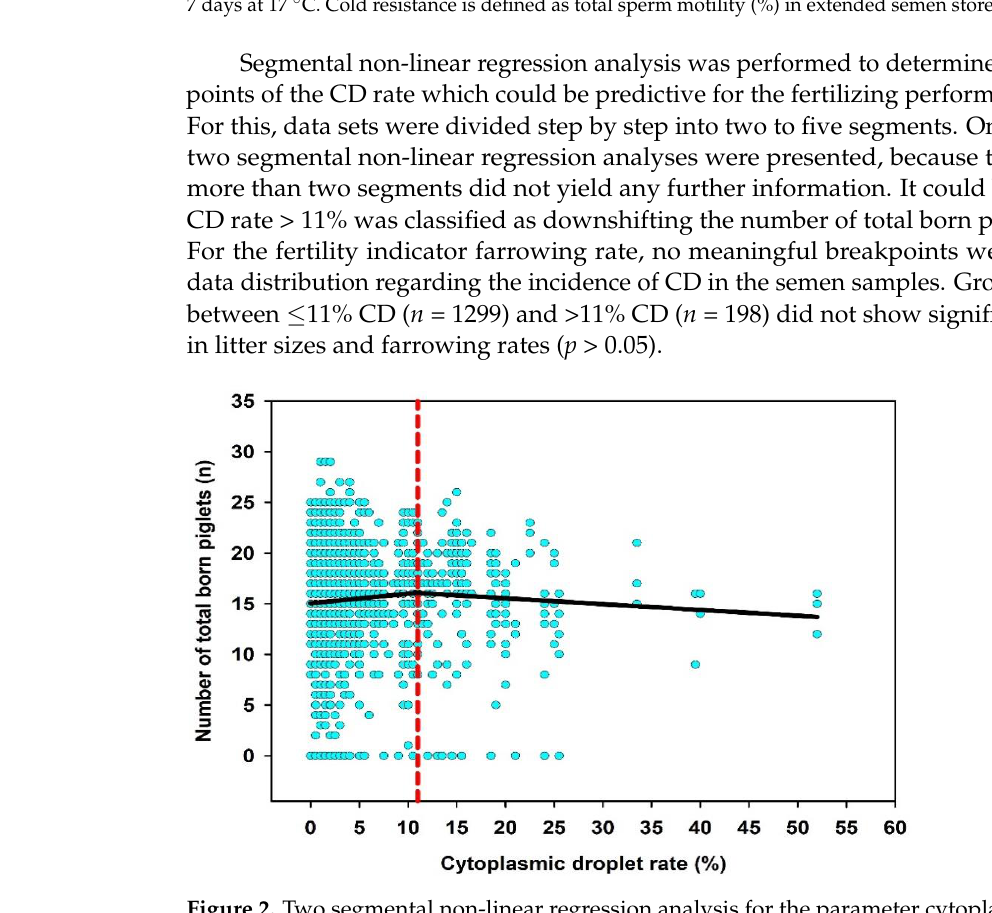
Figure 2. Two segmental non-linear regression analysis for the parameter cytoplasmic droplet rate ( n = 260 ejaculates, two per boar; n = 1497 inseminations records). Table 4. Standard sperm traits ( a ) and functional sperm traits ( b ) regarding three different levels of cytoplasmic droplet (CD) rates in the semen used for insemination: A: low (<10%), B: moderate (≥10% and <15%) and C: high (≥15%). Values are shown as median (interquartile range). Significant differences between the groups are marked by different superscript index letters (a, b).